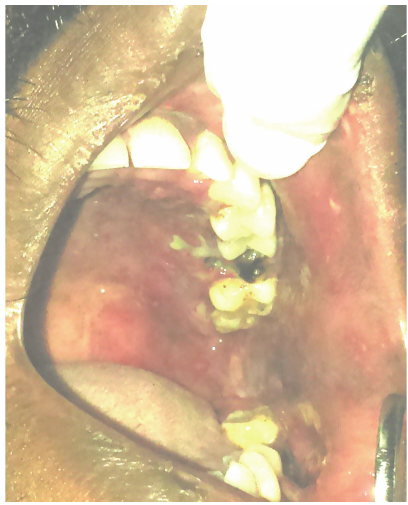
Figure 2: Erosions on palate with necrosis and sloughing in 26 region.